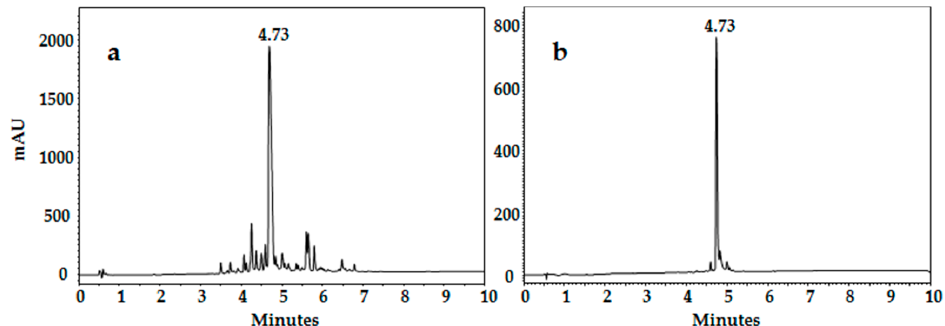
Figure 2. RP-HPLC analysis of Peptide LfcinB 17 – 25. Chromatographic profile of ( a ) crude and ( b ) purified product.